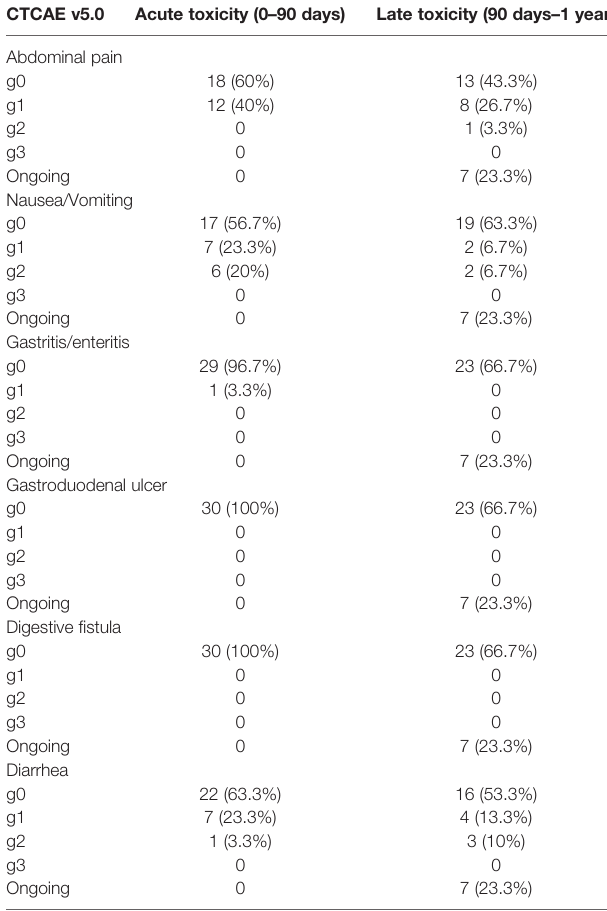
TABLE 5 | SMART-related acute and late toxicities.